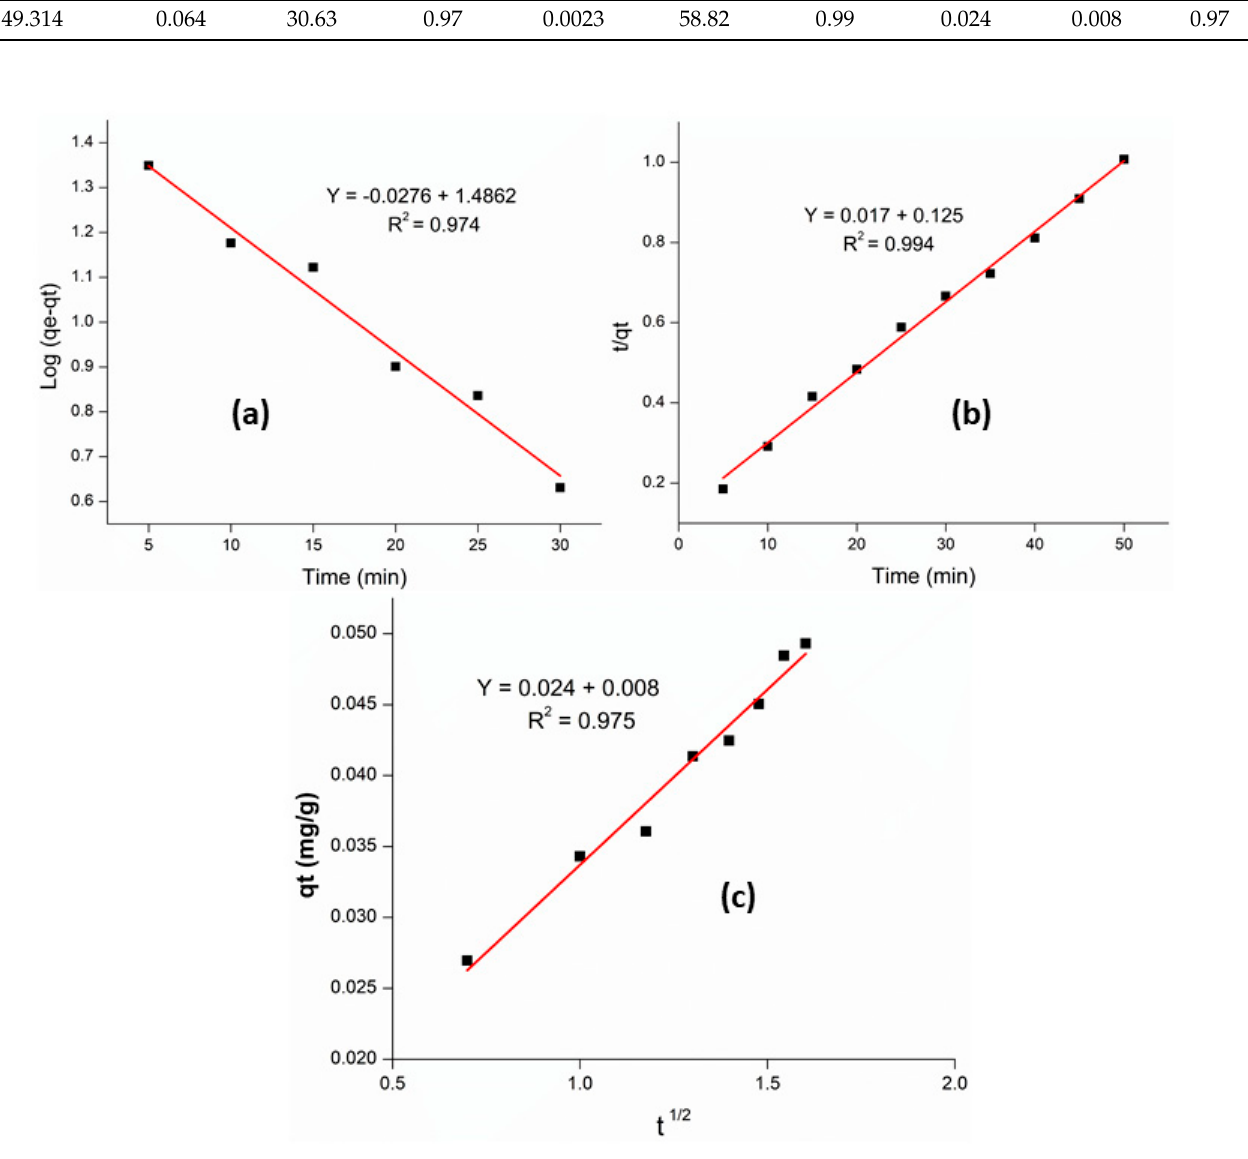
Figure 6. Pseudo 1st order ( a ), pseudo 2nd order ( b ), and intra particle diffusion ( c ) kinetic plot for adsorption of Cr (VI) over M-AC.